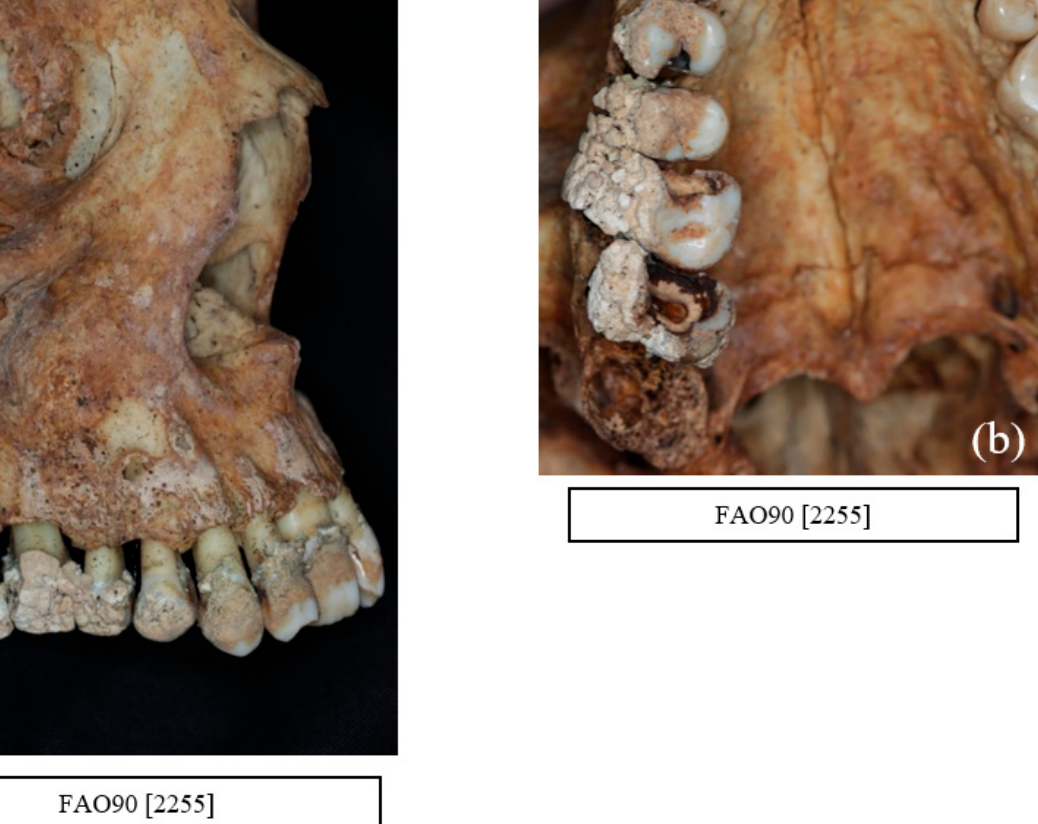
Figure 7. A periapical lesion associated with a retained root of an upper left second incisor tooth (UL2) (courtesy of the Museum of London).